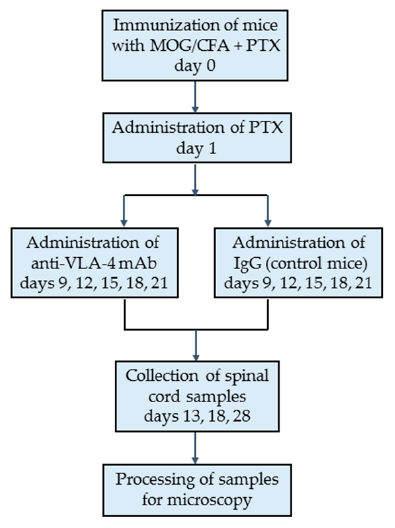
Figure 1. Outline of the